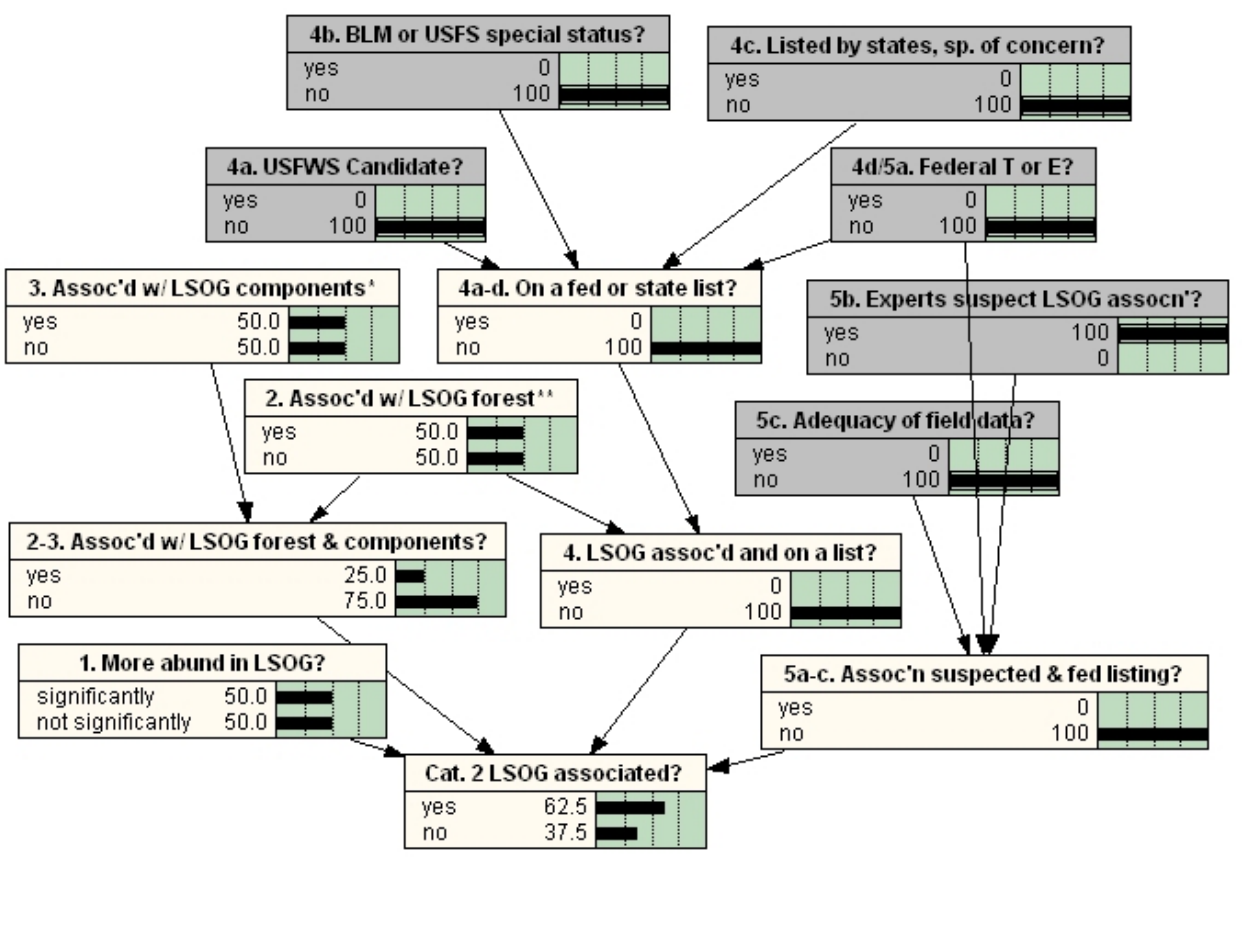
Fig. 3. Bayesian belief network (BBN) submodel for determining evaluation category 2, late- successional and old-growth forest (LSOG) association of the species. See Table 2 for Record of Decision guidelines used to develop this